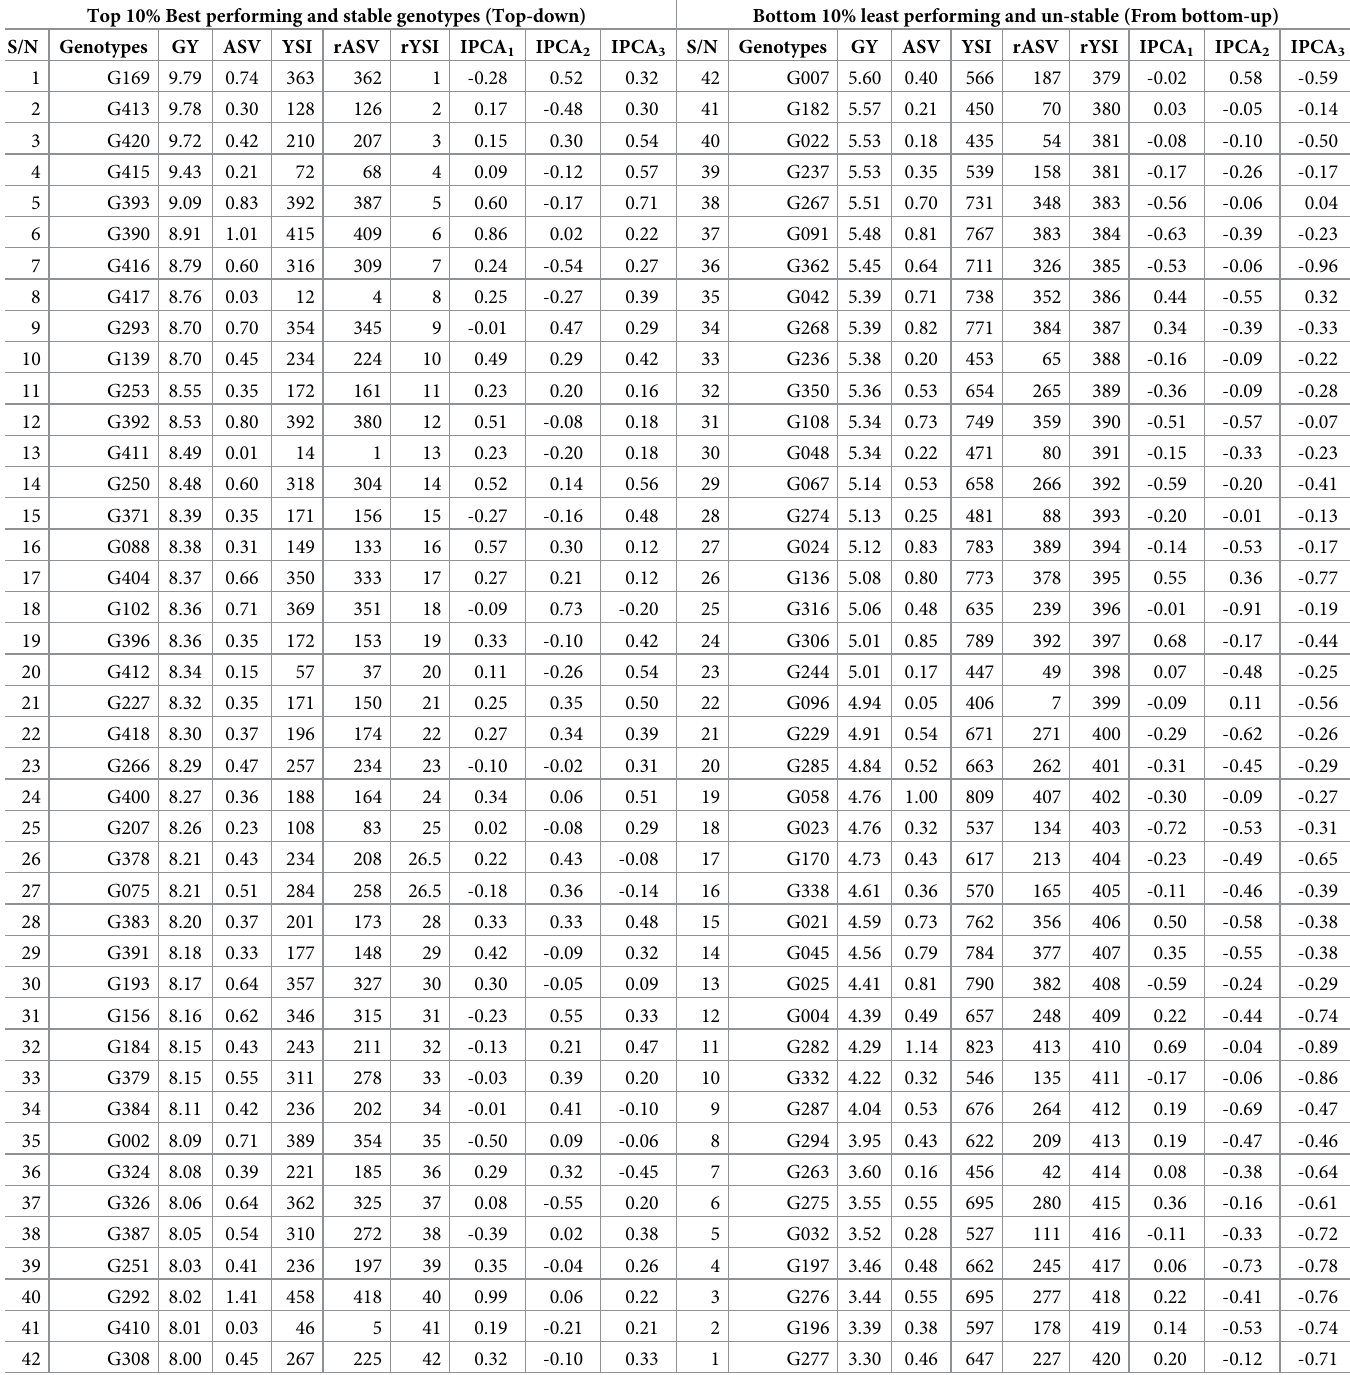
Table 5. The top and bottom 10% of the 420 genotypes in mean grain yield across the five cultivation environments (GY (t ha -1 )) and their corresponding AMMI stability value (ASV), yield stability index (YSI), rank ASV (rASV) and rank YSI(rYSI), as well as their first three interaction principal components (IPC1 –IPC3). Top 10% Best performing and stable genotypes (Top-down) Bottom 10% least performing and un-stable (From